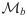
Global RoCoF disturbance magnitude Mb horizontally ranked in increasing order of the squared Fiedler mode amplitude u2b2 on the faulted bus #b.Crosses are for a system with inertia Msys0=14.7 GWs2 (corresponding to today’s European grid, Fig 1) and circles for reduced inertia Msys=0.6Msys0, with system inertia mainly reduced outside Fiedler areas (solid circles) or mainly reduced inside Fiedler areas (empty circles).